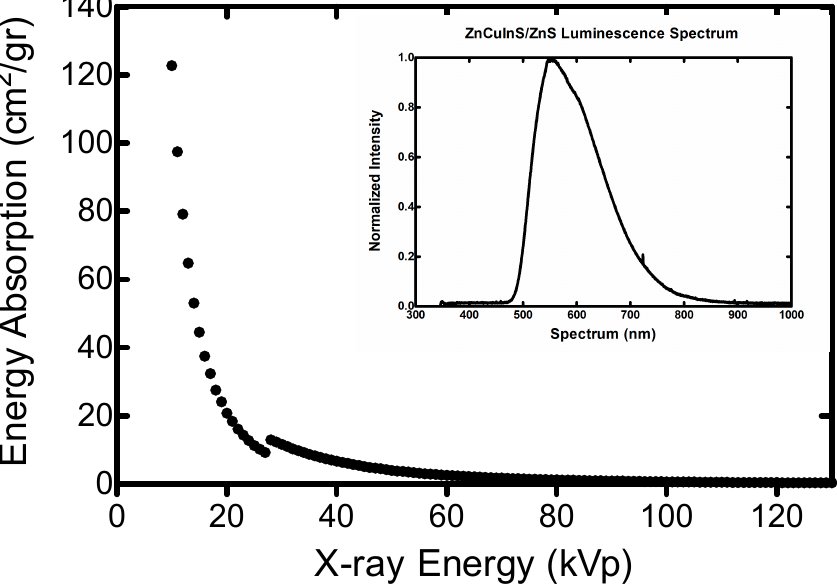
Figure 2. The mass energy absorption coefficient of ZnCuInS/ZnS QDs. The inset shows the QDs’ luminescence spectrum.